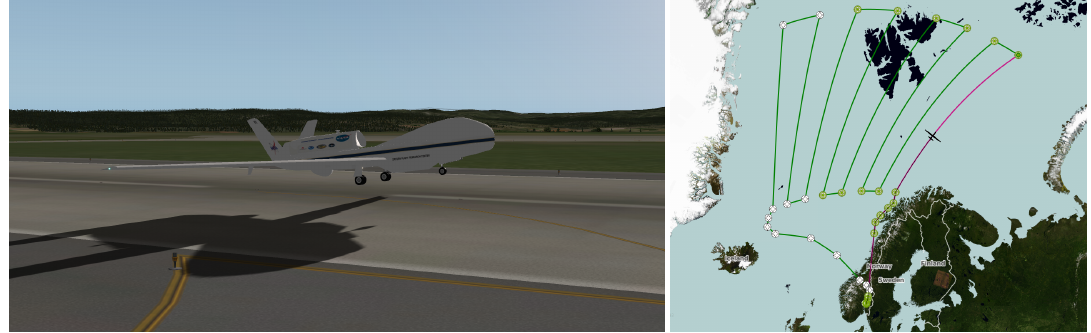
Figure 11. Simulated NS872 taking off from Oslo-Gardermoen airport and its high-altitude mission over the North